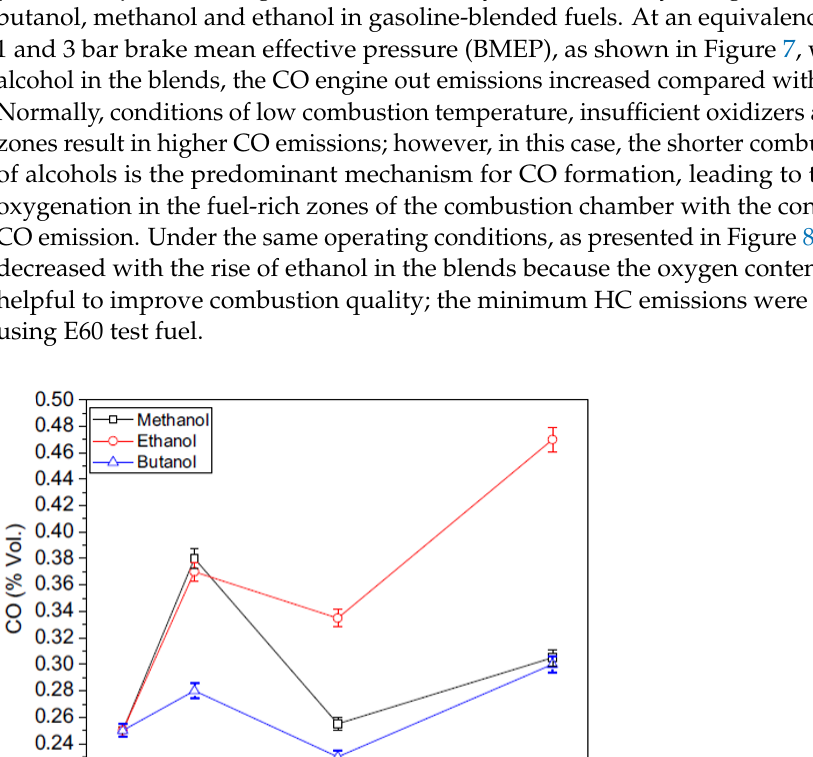
Figure 8. Variation in HC emissions with alcohol content in the blends at 3 bar BMEP and equiva- lence ratio ϕ = 1: comparison between methanol, ethanol and butanol [95]. Reproduced with per- mission from Applied Thermal Engineering; published by Elsevier, 2017. License Number: 5094081168292. For the same multi-port fuel injection engine, the effect of gasoline blended with 30% v/v ethanol on the CO and HC emissions was also analyzed under different engine loads and equivalence ratios fluctuating from 0.83 to 1.25. It was found that, for each test fuel, the equivalence ratio controls CO emission only under reach conditions (Figure 9); on the other hand, under lean conditions, CO emissions do not vary significantly and are much lower compared to rich conditions due to the resultant high oxygen content, which im- proves the oxidation process. In Figure 9, it is also evident that, with adding ethanol in the fuel blends at 3 bar BMEP, CO emissions decrease at rich conditions while they in- crease at stoichiometric conditions. In Figure 10, HC exhaust emissions increase under rich conditions for each test fuel and for both engine loads due to the incomplete combus- tion process as the combustion quality worsens. E30 test fuel (30% ethanol v/v) revealed